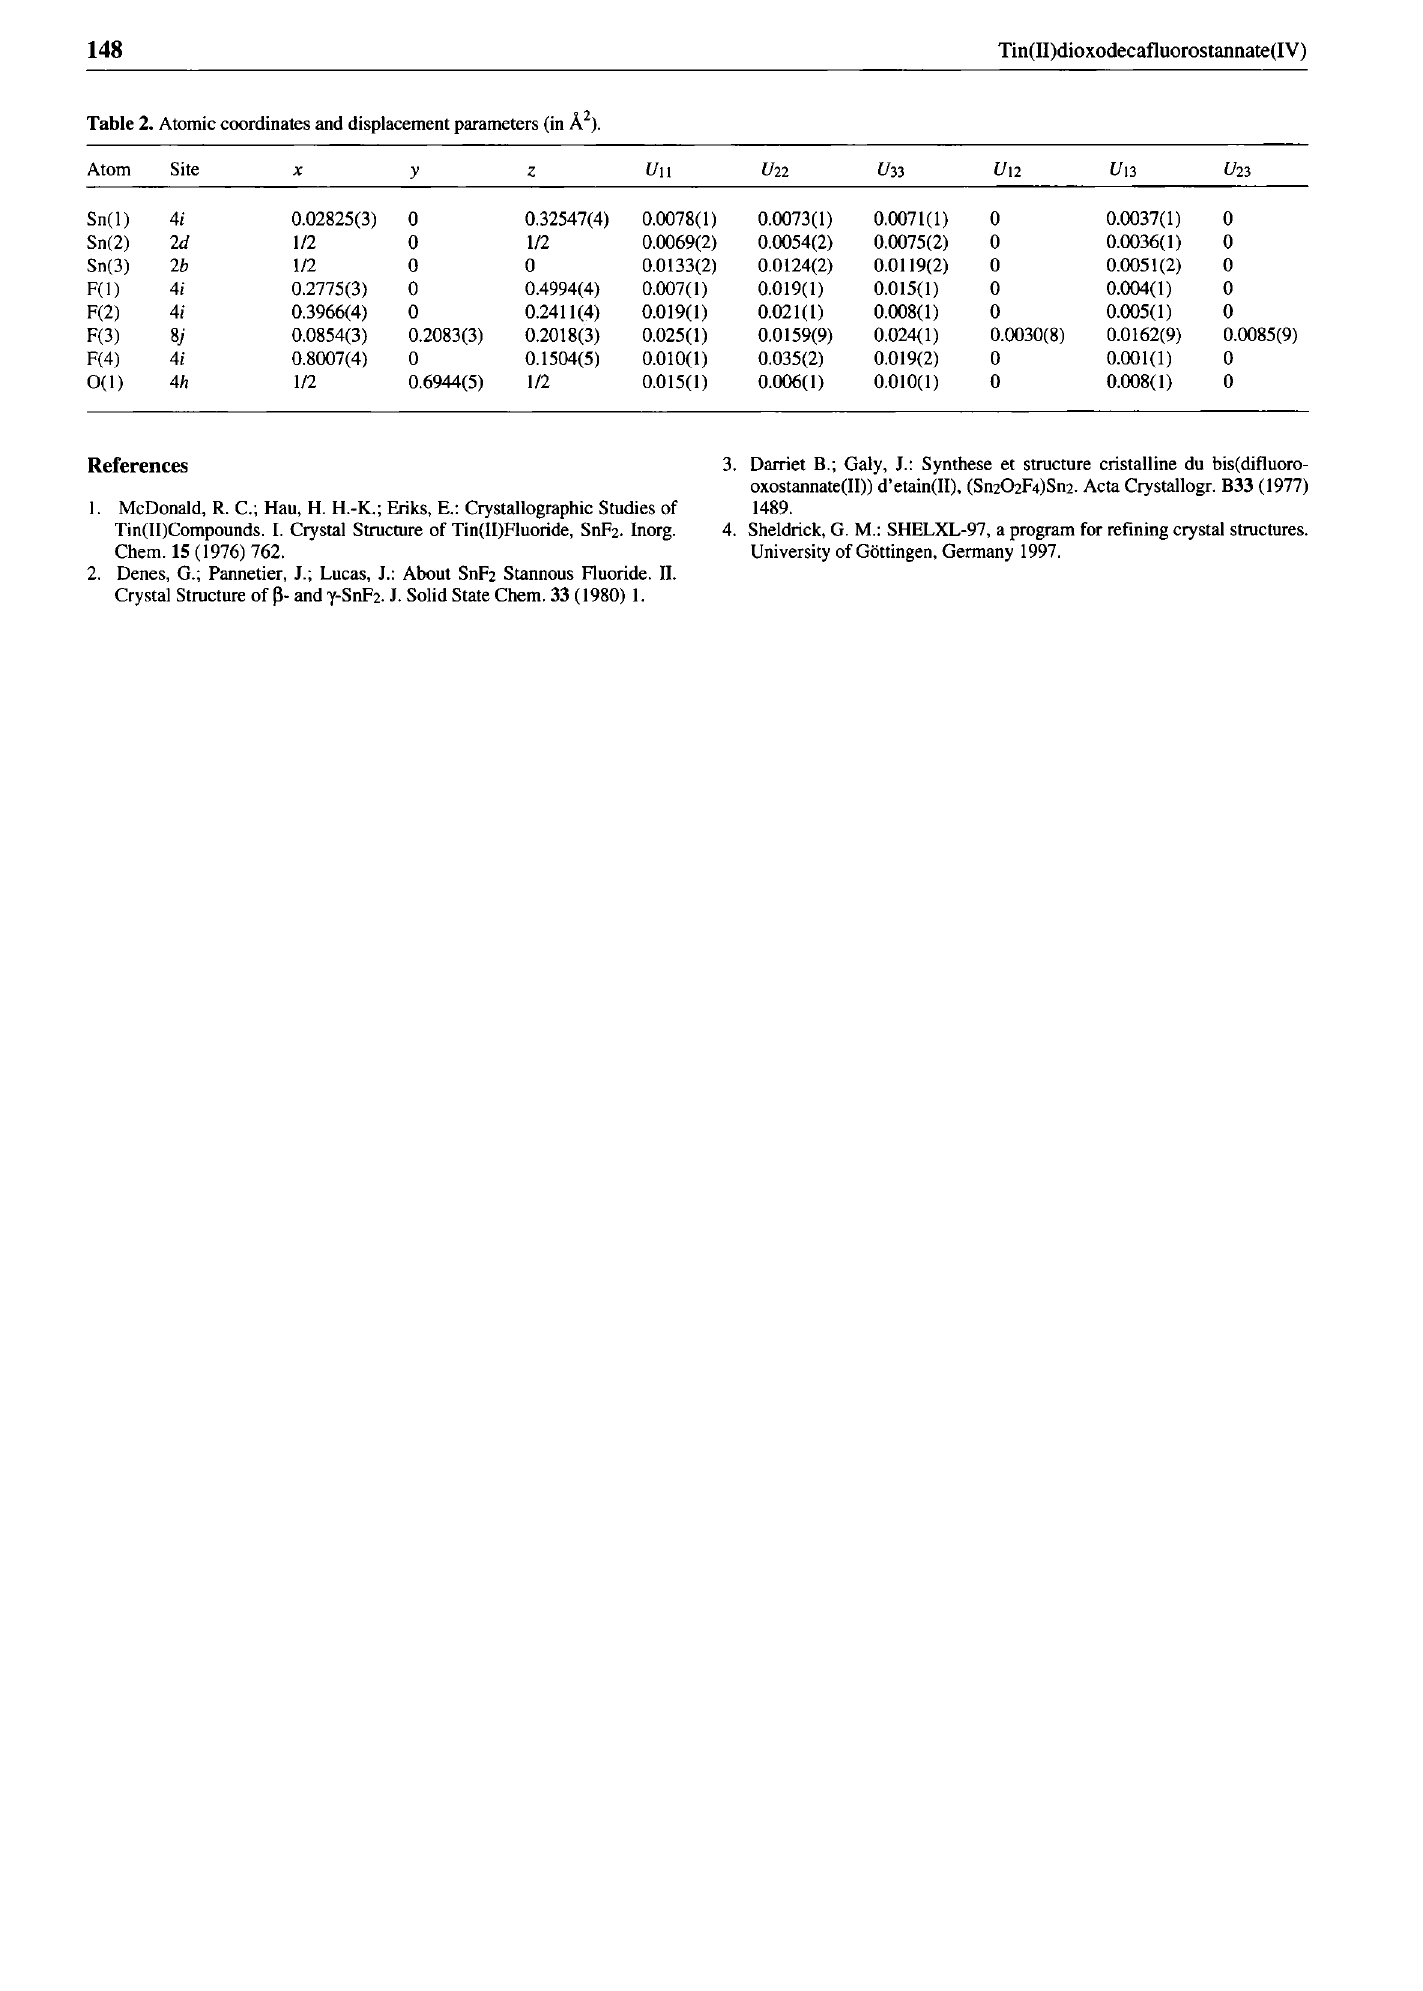
Table 2. Atomic coordinates and displacement parameters (in Ä 2